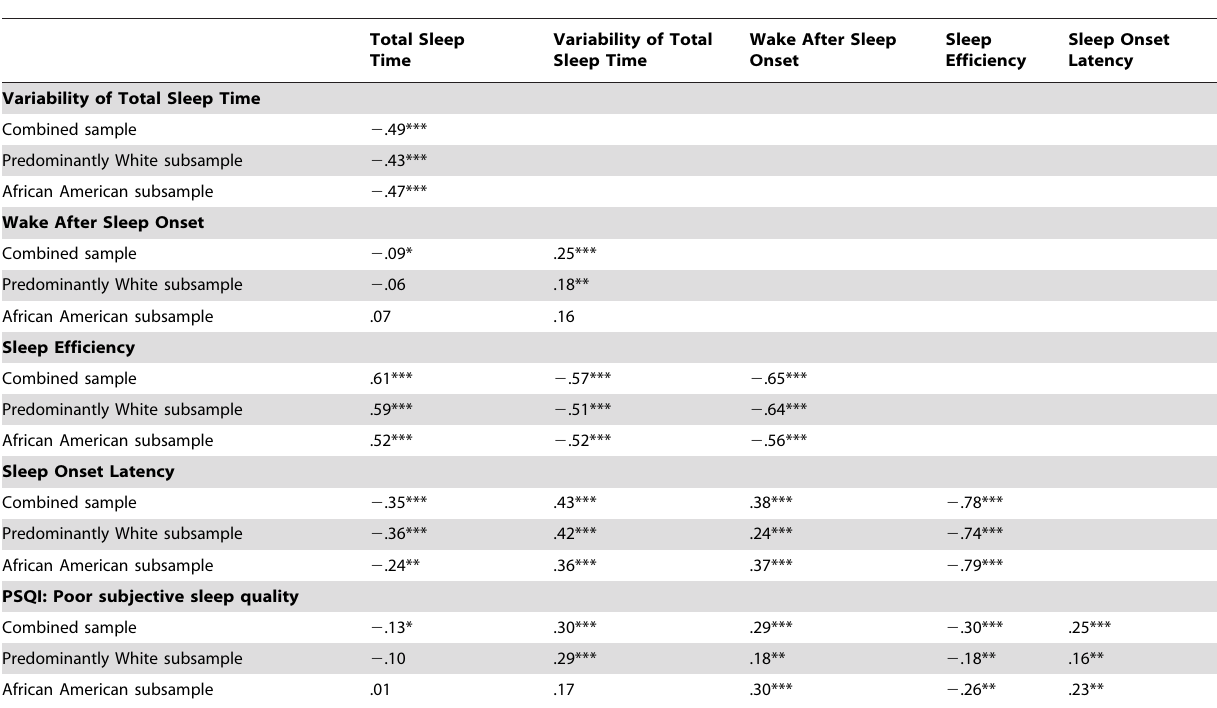
Table 2. Zero-order correlations between sleep indicators.